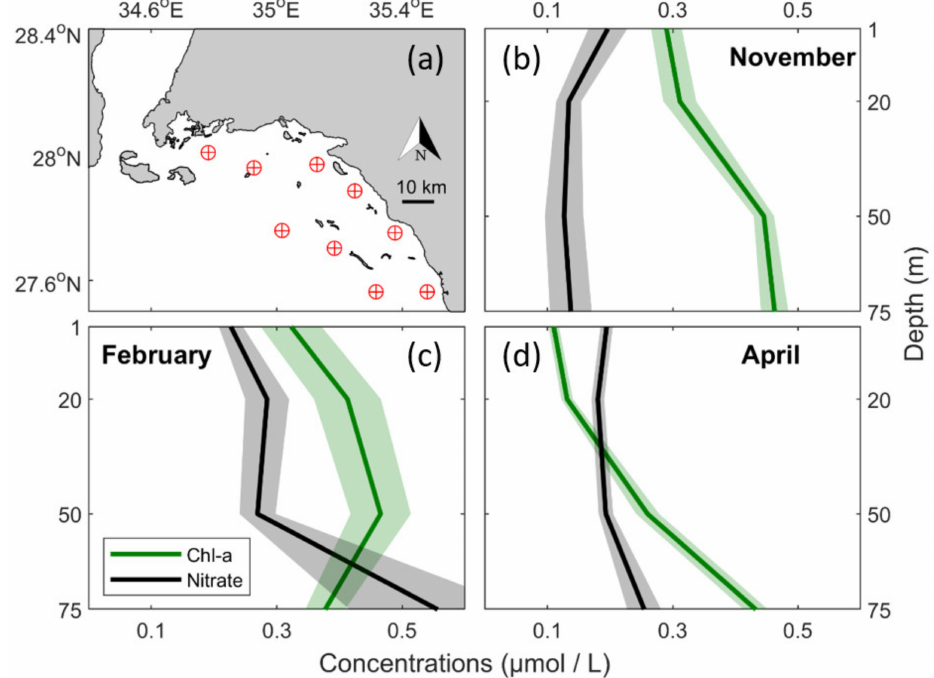
Figure 4. In situ measurements of Chl-a and nitrate taken during three research cruises in the NEOM region in 2017–2018. The locations of the sampling stations are shown in panel ( a ). Vertical profiles for Chl-a and nitrate are presented during: ( b ) November, ( c ) February and ( d ) April. Samples were collected at depths of 1, 20, 50 and 75